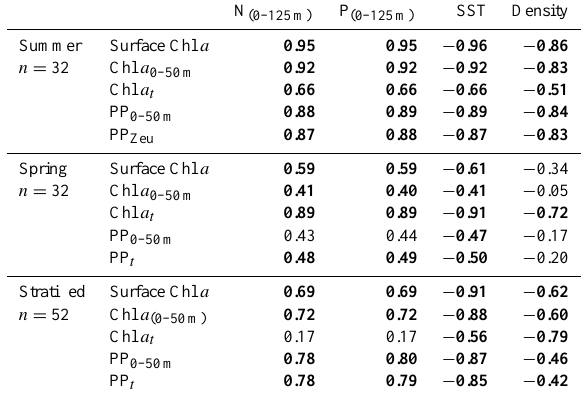
Table 2. Spearman rank-order correlation coefficients of nitrate (N) and inorganic phosphate (P) concentrations in the potential euphotic zone (0–125m), sea surface temperature (SST), and density differ- ences in the upper 200m (density) versus phytoplankton biomass and productivity. Surface chlorophyll a (surface Chl a) , Chl a in the upper euphotic zone (Chl a 0–50m ), and Chl a integrated from the surface to 200–410m (Chl a t ) were used as biomass indicators. Productivity in the upper euphotic zone (PP 0–50m ) and productivity in the euphotic zone (PP Zeu ) were used as indicators for productiv- ity. Data are shown for spring and summer cruises ( n = 32), and for the stratified stations from both cruises ( n = 52). Significant corre- lations are expressed in bold.